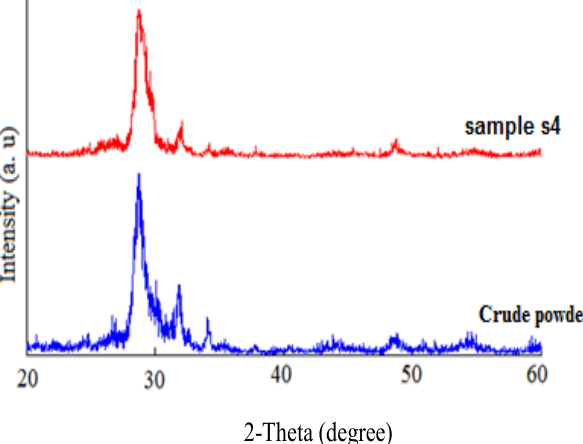
Fig. 1. The patterns of x ray diffraction in various states of mechan- ical